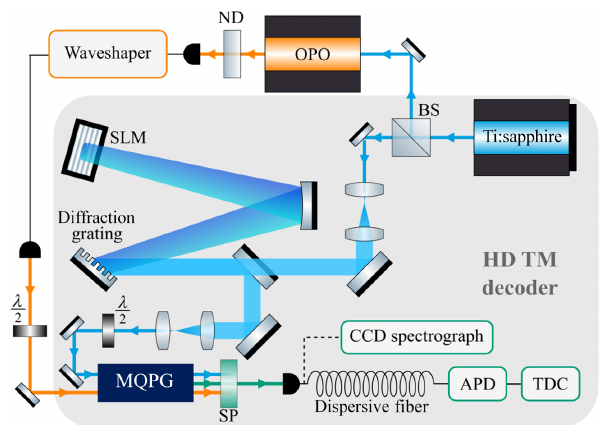
FIG. 4. The experimental setup. A portion of the pump beam (blue line) generated by the Ti:sapphire laser is directed to a 4- f line based on a spatial light modulator (SLM). The shaped beam travels back through the folded configuration at a lower angle than the incoming beam, so as to be picked up by a short mir- ror and to be coupled into the MQPG waveguide. The remaining part of the Ti:sapphire beam pumps an optical parametric oscil- lator (OPO) that generates the input beam (orange line) of the experiment at telecommunication wavelengths. The input beam is attenuated to the single-photon level by neutral-density filters (ND) and is shaped with use of a commercial waveshaper, before being coupled into the MQPG waveguide. The output field (green line), isolated by a short-pass filter (SP), is detected either with a commercial CCD spectrograph or with a TOF spectrograph consisting of a dispersive fiber, an avalanche photodiode (APD), and a time-to-digital converter (TDC). The gray area indicates the components of our high-dimensional (HD) TM decoder (for more information, see the main